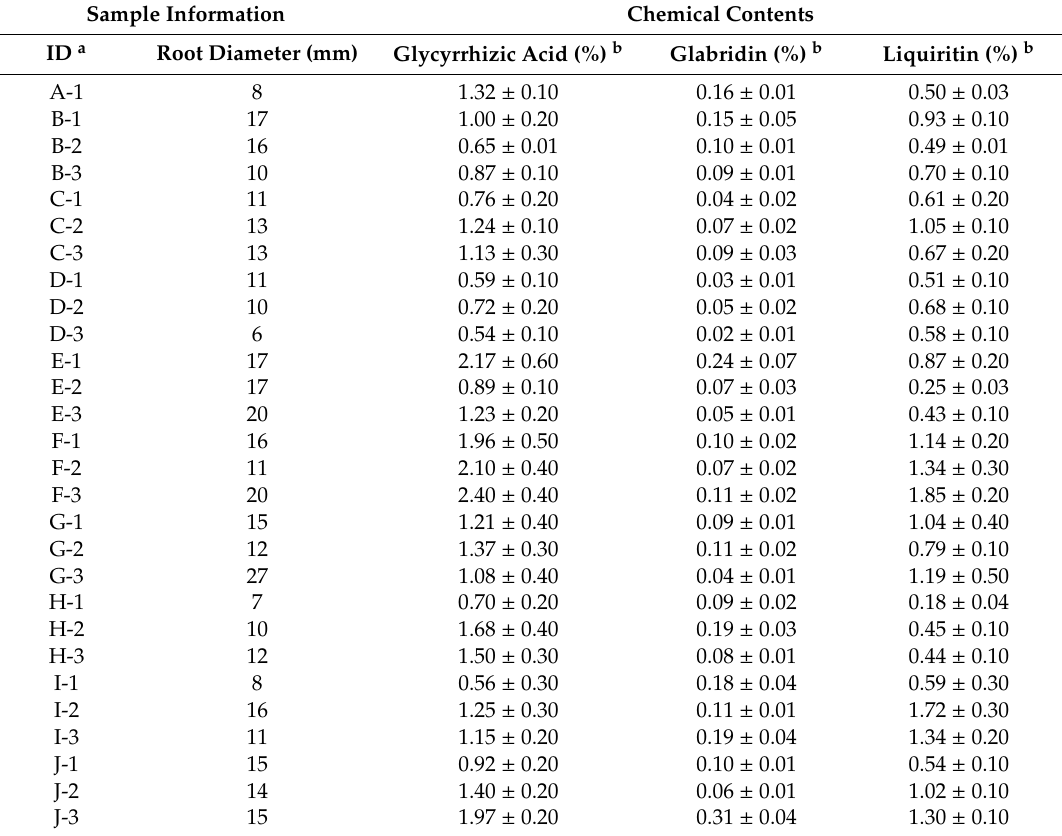
Table 1. Chemical contents analyzed with